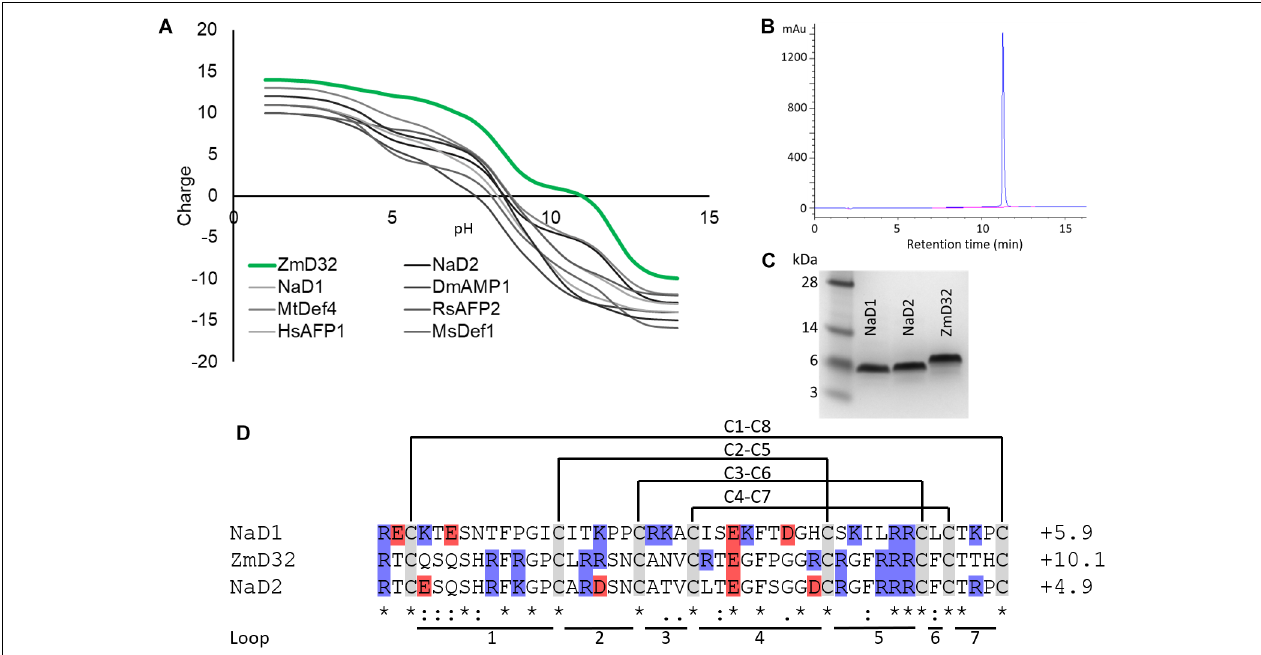
FIGURE 1 | Sequence analysis and purification of ZmD32. (A) The charge on defensins at pH 1–14 was estimated by running the sequences through PROTEIN CALCULATOR v3.4 (http://protcalc.sourceforge.net/). ZmD32 was more highly charged across all pHs than other defensins in the literature (Terras et al., 1992; Thevissen et al., 2000; Lay et al., 2003; Dracatos et al., 2014). (B) RP-HPLC trace of purified ZmD32 revealed a single peak. (C) SDS-PAGE analysis of ZmD32 alongside two other defensins NaD1 and NaD2. ZmD32 runs higher on the gel compared to the other two defensins despite the predicted molecular masses being similar (ZmD32 5529 Da, NaD1 5296 Da, NaD2 5255 Da). The mass of ZmD32 was confirmed by MALDI-TOF MS (data not shown). (D) Alignment of the sequence of ZmD32, NaD2 and NaD1 was performed using Clustal Omega (www.ebi.ac.uk/Tools/msa/clustalo/). The symbol “ ∗ ” indicates amino acids common to all three sequences and “:” indicates amino acids with strongly similar properties and. amino acids with weakly similar properties. The charge of each defensin at pH 7 is presented to the right of the sequence. Positively charged residues are highlighted in blue, negatively charged residues in red and cysteines in gray. NaD2, which shares 78.7% sequence identity with ZmD32, was included as a comparator because the α NaD2 antibody was used to detect ZmD32 in subsequent